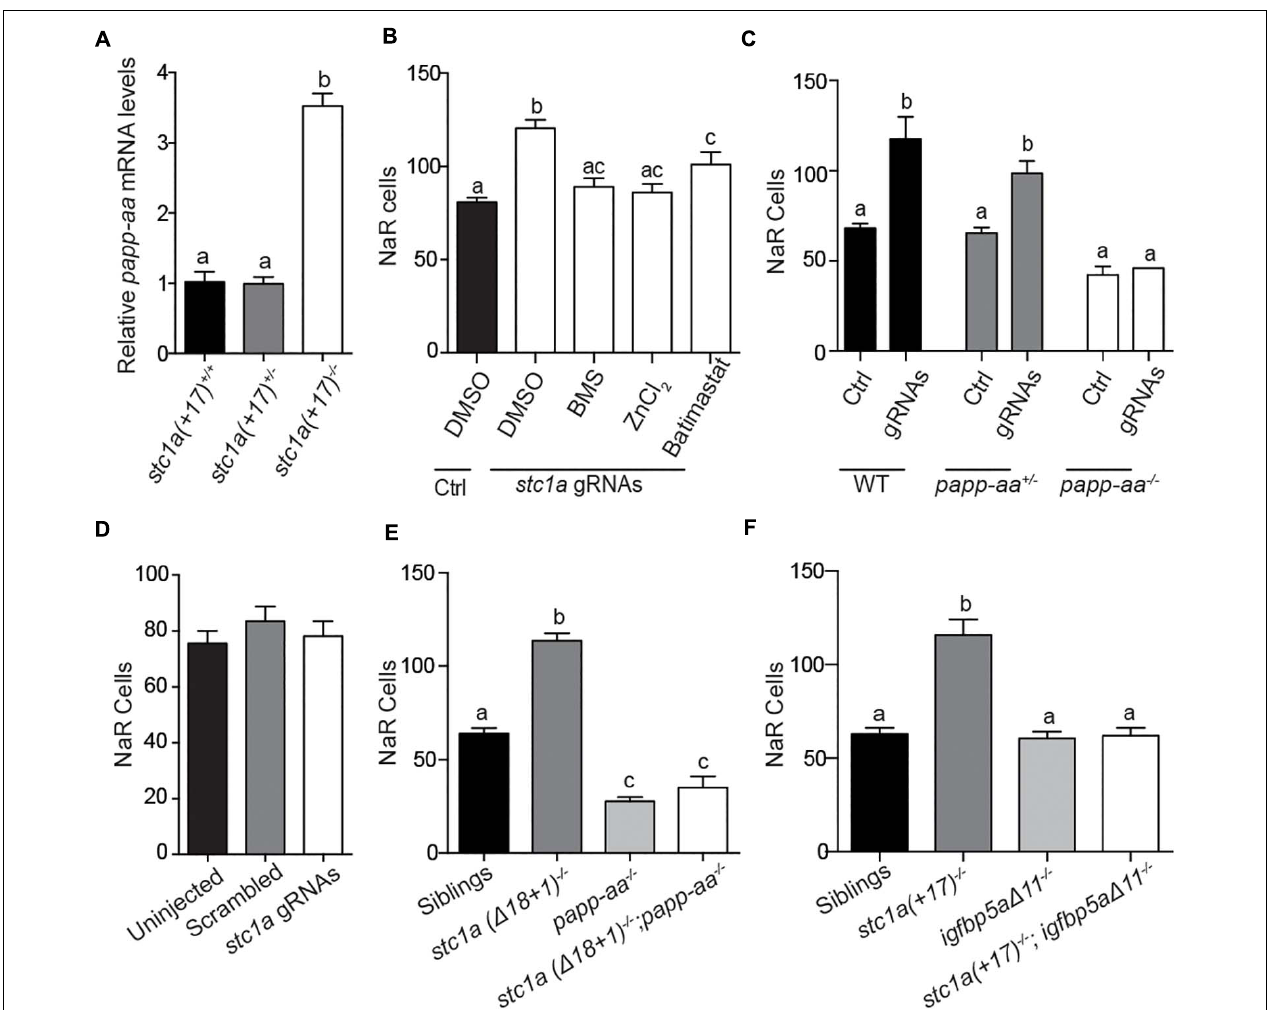
FIGURE 4 | Papp-aa and Igfbp5a are indispensible for Stc1a action in NaR cells. (A) Embryos of the indicated genotypes were raised in E3 embryo medium until 5 dpf. The mRNA levels of papp-aa were measured and normalized. n = 15–17 larvae/group. (B) Tg(igfbp5a: GFP) embryos were injected with stc1a targeting gRNAs and Cas9 mRNA at the 1-cell stage. Embryos were raised in E3 embryo medium. The injected embryos were treated with BMS-754807 (BMS, 0.3 µ M), ZnCl 2 (8 µ M), or Bastimastat (200 µ M) from 3 to 5 dpf. NaR cells were quantified and shown. n = 20–39 larvae/group. (C,D) Progeny of papp-aa + / − ; Tg (igfbp5a: GFP) intercrosses (C) or igfbp5a - / - ; Tg (igfbp5a: GFP) intercrosses (D) were injected with stc1a targeting gRNAs and Cas9 mRNA. The injected embryos were raised and NaR cells were quantified at 5 dpf. Each larva was genotyped afterward. n = 5–19 larvae/group (C) and n = 39–43 larvae/group (D) . (E,F) Larvae of the indicated genotypes were raised in E3 embryo medium and NaR cells were quantified at 5 dpf. n = 9 ∼ 78 larvae/group (E) and n = 4 ∼ 34 larvae/group (F)